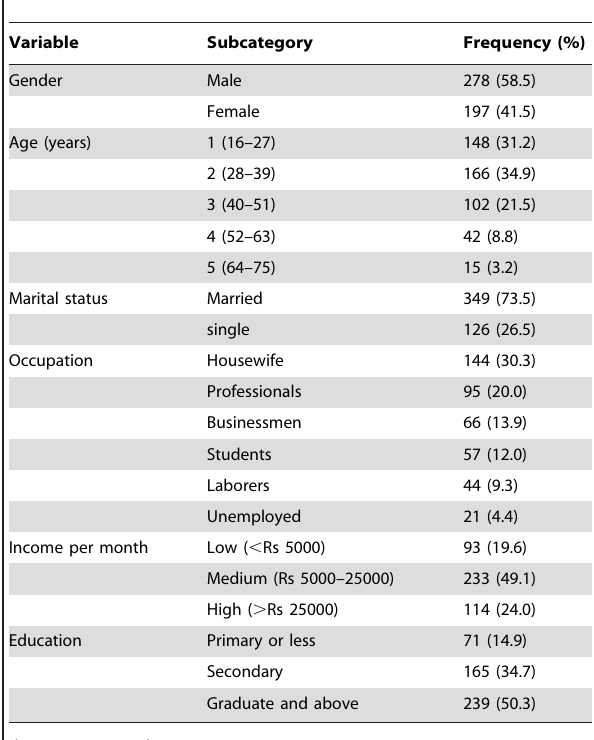
Table 1. Demographic Distribution